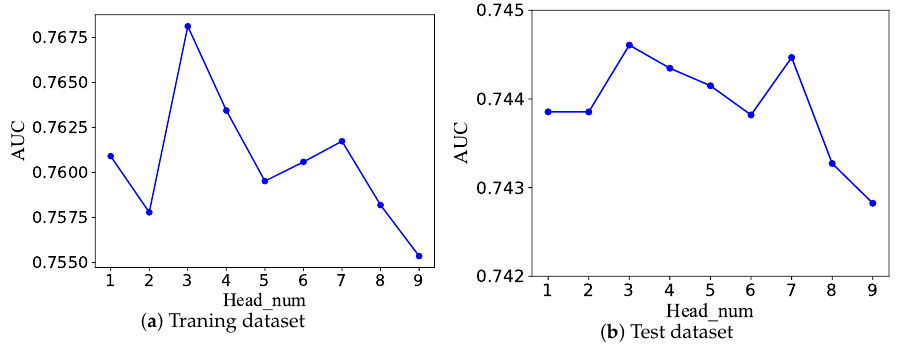
Figure 4. Influence of Head Number on ContextKT’s Performance.